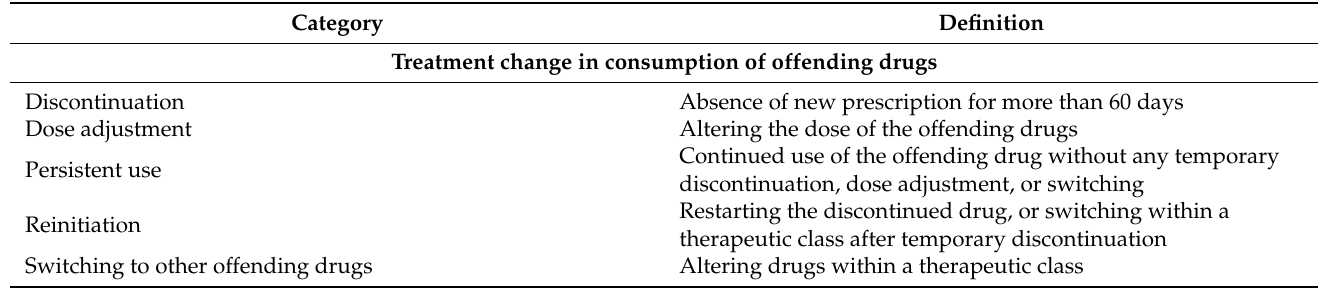
Table 1. Definitions of treatment change and prognosis after incident drug-induced